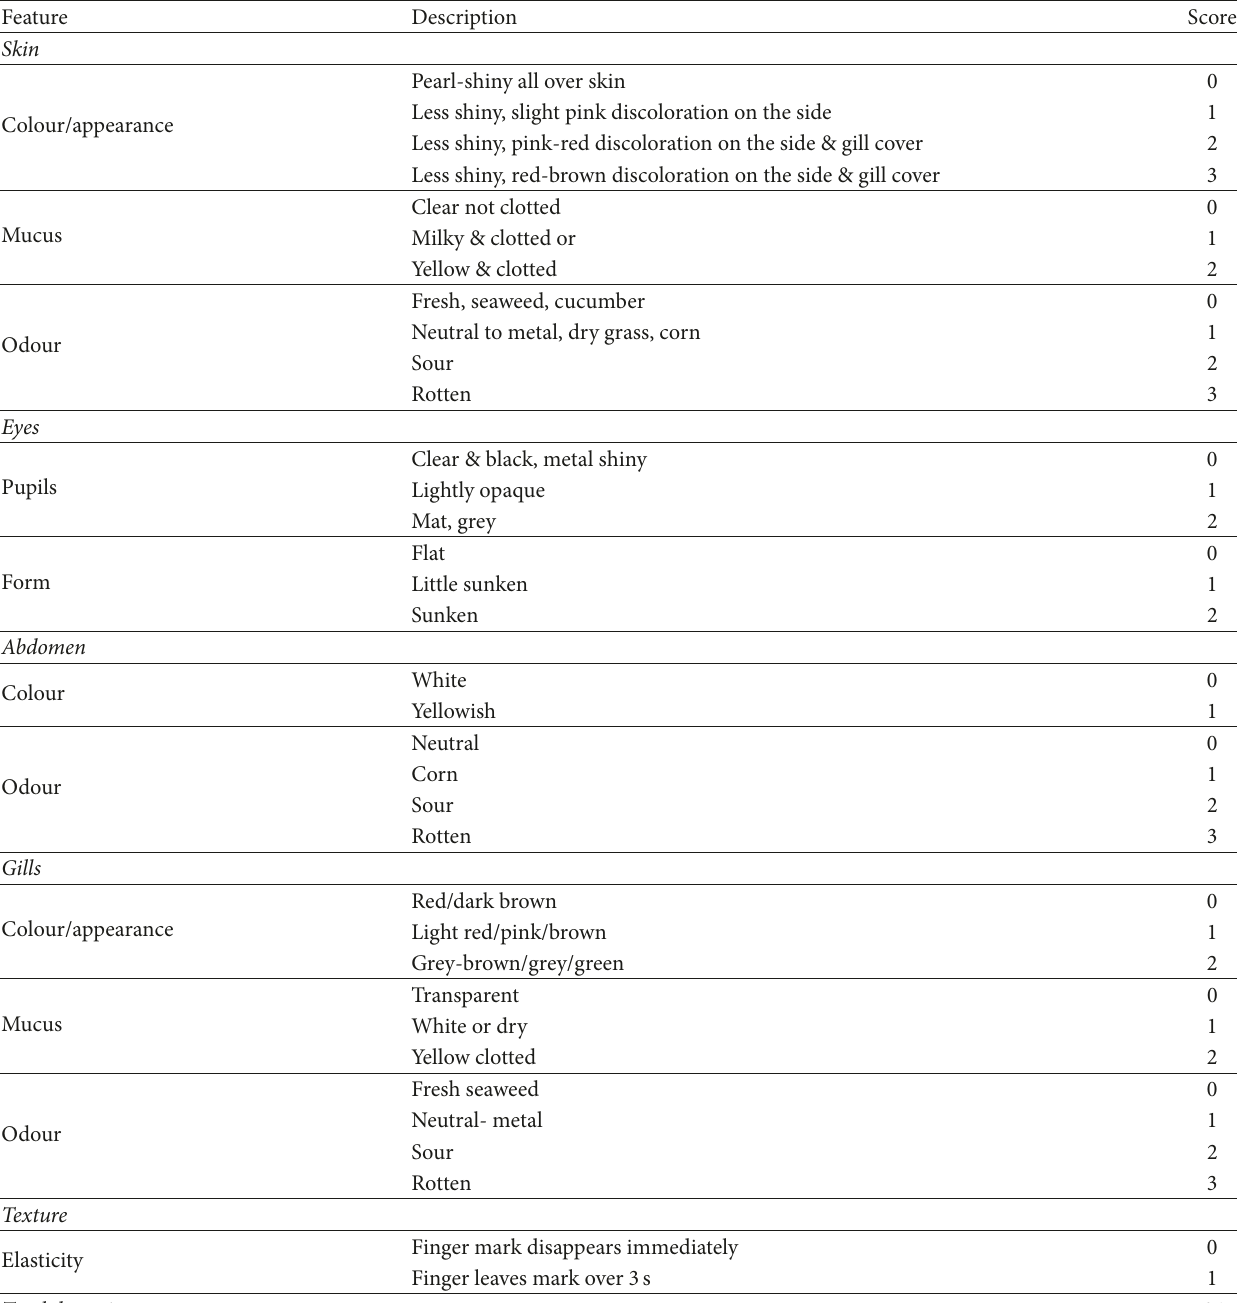
Table 4: QIM scheme developed for rainbow trout (Oncorhynchus mykiss)